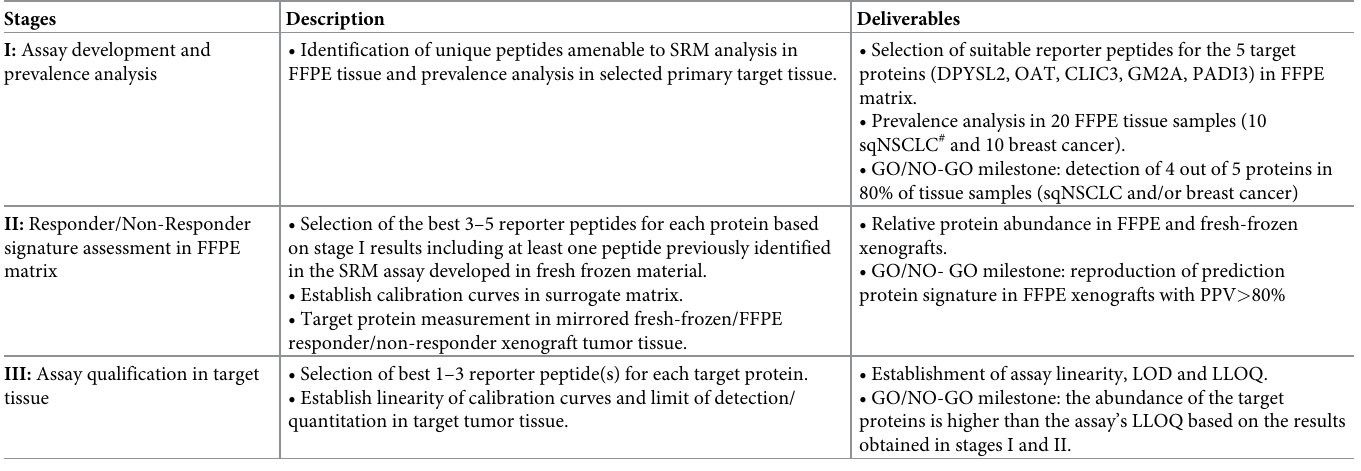
Table 1. Assay development and qualification plan for the 5-protein signature in FFPE breast cancer